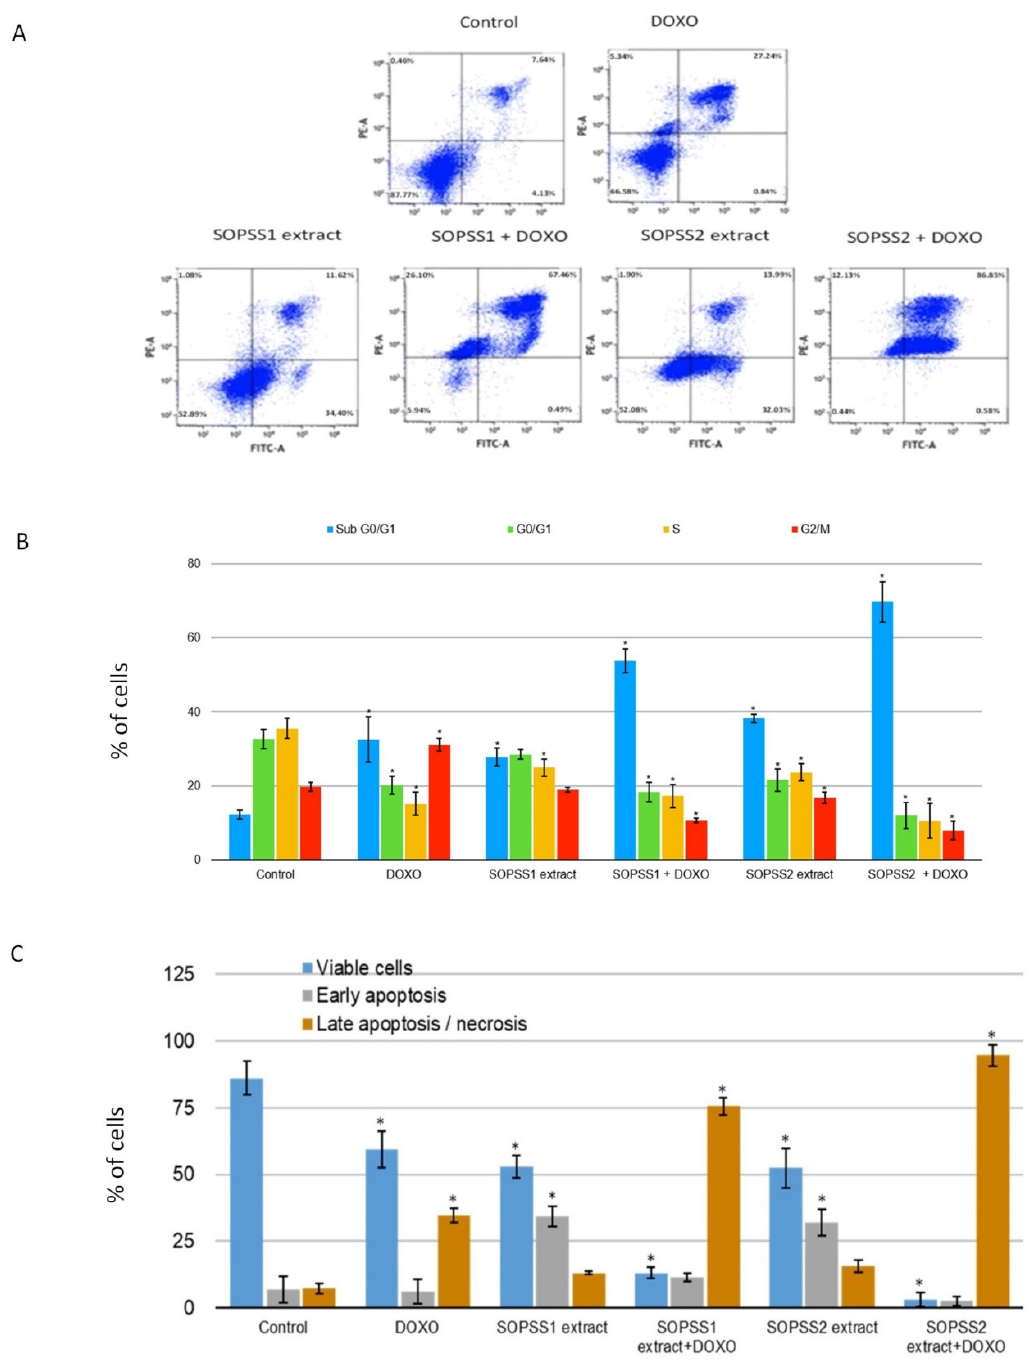
Figure 8. ( A ) Apoptosis induction by transgenic SOPSS1 and SOPSS2 root extracts at their IC 50 alone or in combination with doxorubicin on NALM6 cells for 24 h determined by Annexin V-FITC / PI flow cytometry-representative cytograms. ( B ) The diagram shows the percentage of the cell population in each phase of the cell cycle in NALM6 cells after 24-h treatment with SOPSS1 and SOPSS2 root extracts (alone or combination with doxorubicin). ( C ) Diagram shows percentage of cell populations divided to viable cells, early apoptotic, late apoptotic / necrotic cells. Data represent the mean ± SD of three independent experiments. * p < 0.05 SOPPS1 or SOPSS2 (alone or in combination with doxorubicin) vs. control.